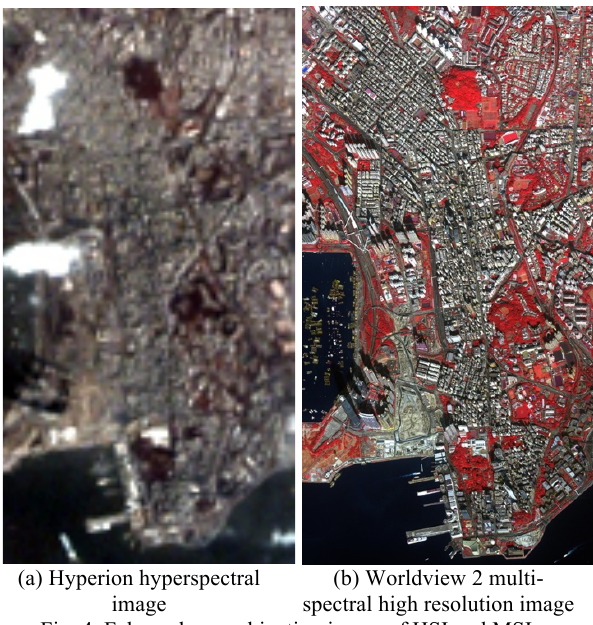
Fig. 4. False color combination image of HSI and MSI.